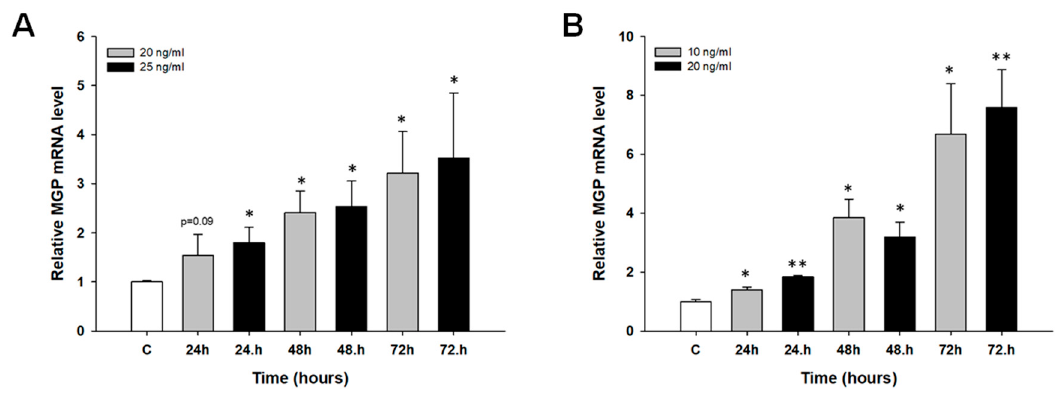
Figure 5. Expression analysis of MGP gene in A2780 cell line after short time exposure to PAC ( A ) and TOP ( B ). The figure presents relative genes expression in PAC or TOP treated cells (grey and black bars) with respect to the untreated control (white bars) assigned as 1. The values were considered significant at * p < 0.05, and ** p < 0.01.